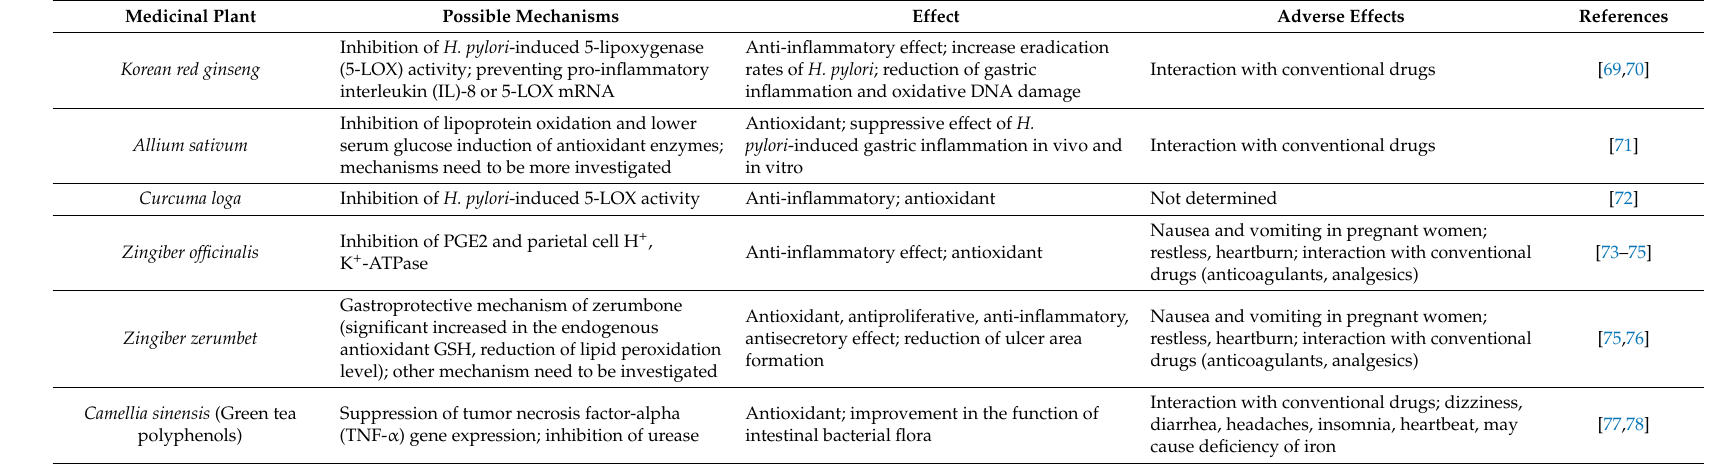
Table 3. Overview of herbal antiulcer treatment and H. pylori